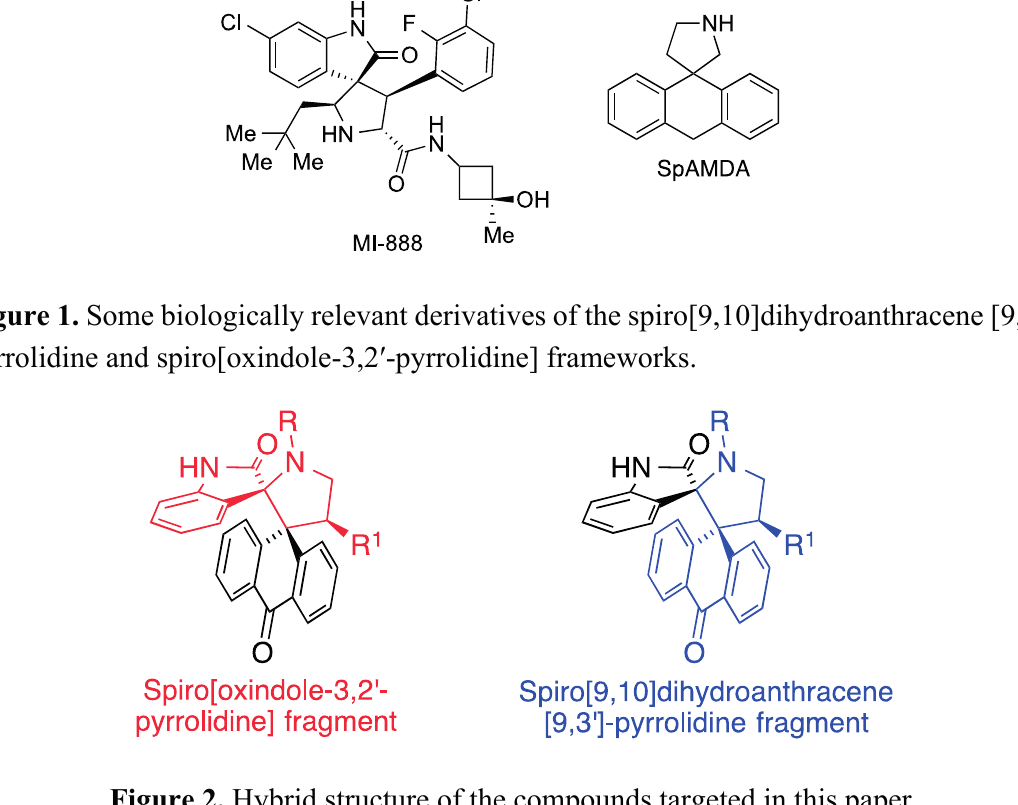
Figure 2. Hybrid structure of the compounds targeted in this